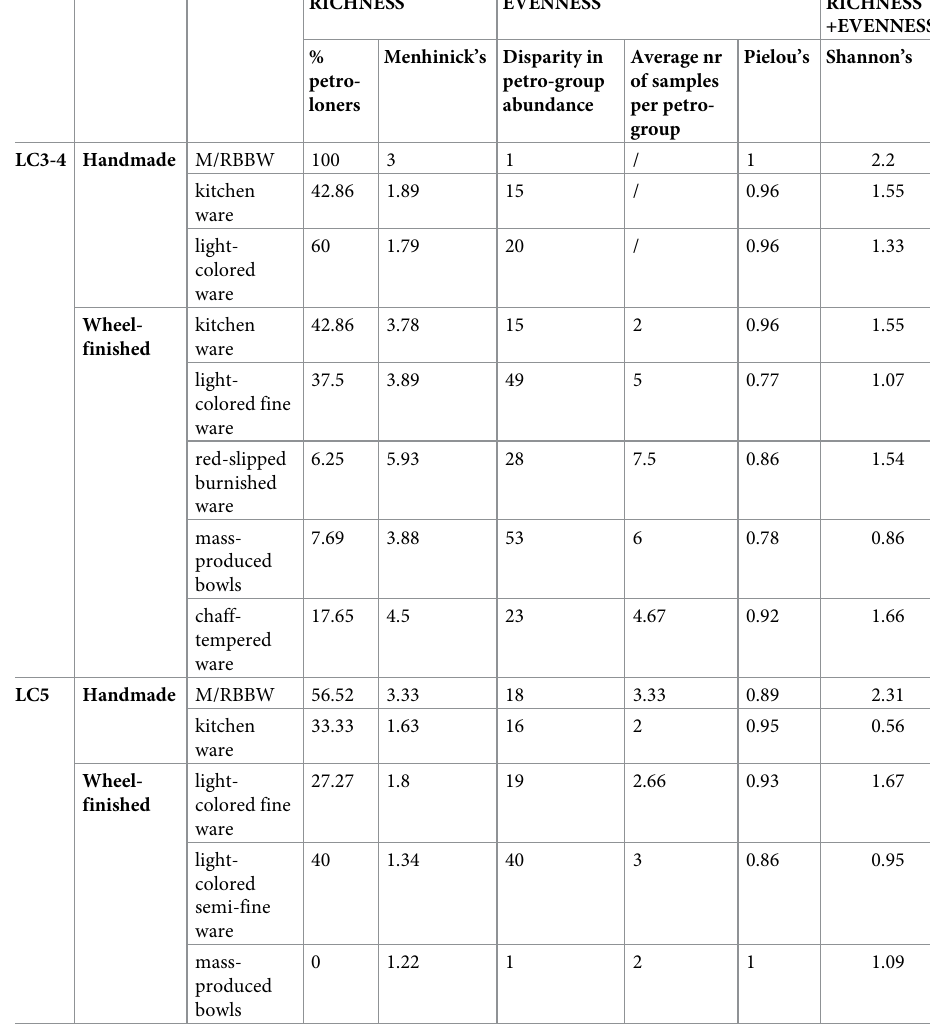
wheel-finished wares (Table 12), the mass-produced bowls still show the lowest petrographic richness, as in the previous phases, but evenness is now higher than in other wheel-finished vessels. Indeed, Pielou’s index provides higher values and thin sections are more evenly distrib- uted across petrographic groups. When we compare vessel categories that recur both in the LC3-4 and LC5, interesting dia- chronic trends emerge. Diversity indexes change differently through time according to form- ing techniques. The handmade production shows an unequivocal trend from the LC3-4 to LC5 towards a petrographic homogenization in terms of both richness and evenness, while the wheel-finished production tends to lose in homogeneity (Table 11) despite an increased use of rotating devices in LC5. With time the values of almost all diversity indexes increase and petro-group sizes decrease. As for mass-produced bowls (Table 12), although always more homogenous than other coeval wheel-finished wares, they do not show univocal trends when